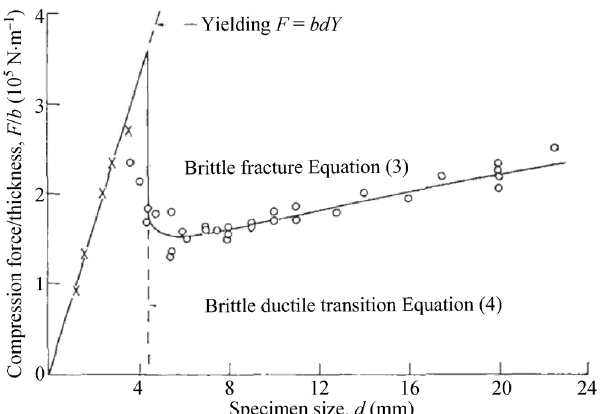
Fig. 4 Compression results obtained by K. Kendall for a range of specimen sizes illustrating cracking (°) for large samples and yielding (×) of small ones. Reproduced from Ref.